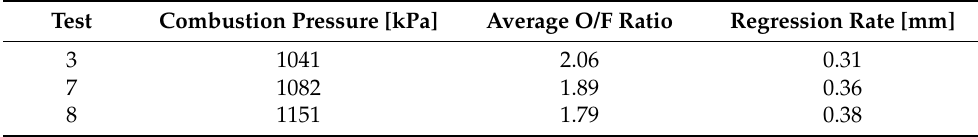
Figure 14. Comparison of combustion pressures in tests 7 and 8. Table 3. Comparison of O/F ratio and regression